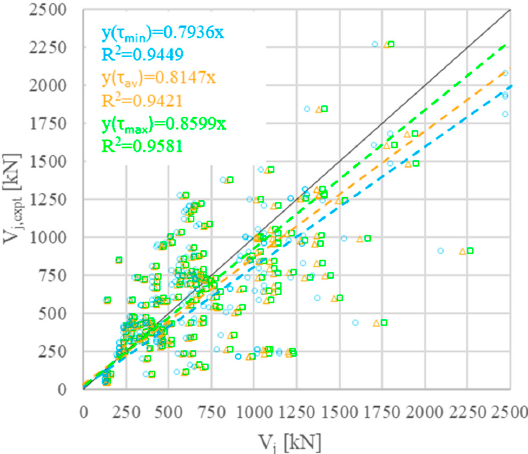
Figure 9. Experimental and numerical comparison for X-shaped RC joints: minimum bond stress (blue), average bond stress (orange), and maximum bond stress (green).